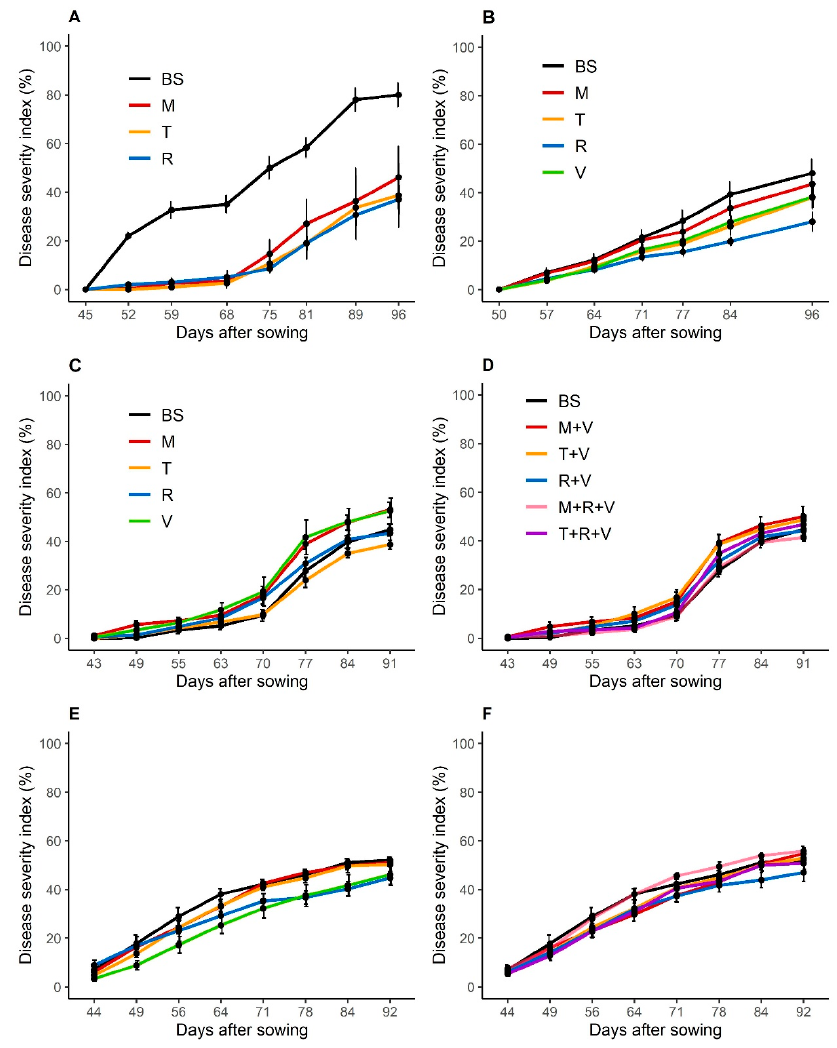
Figure 5. Annual disease severity index (%) progress curves of sunflower verticillium wilt in 2016 ( A ), 2017 ( B ), 2019 ( C , D ) and 2020 ( E , F ). Sunflower cultivar cv. 1 ( A , B ) and cv. 2 ( C – F ) were cultivated after a bare soil, a Brassicaceae or a Fabaceae cover crop in sole crops ( A , B , C , E ), or in a mixture with one Brassicaceae and one Fabaceae, or two Brassicaceae and one Fabaceae ( D , F ). In 2019, the turnip rape did not grow in the mixture with fodder radish and purple vetch. The number of sunflowers recorded was 300 in 2016 ( A ), 675 in 2017 ( B ), and 900 in 2019 ( C , D ) and 2020 ( E , F ). Abbreviation letter refers to the treatments with BS for bare soil, M for brown mustard, T for turnip rape, R for fodder radish and V for purple vetch. Error bars represent standard errors .